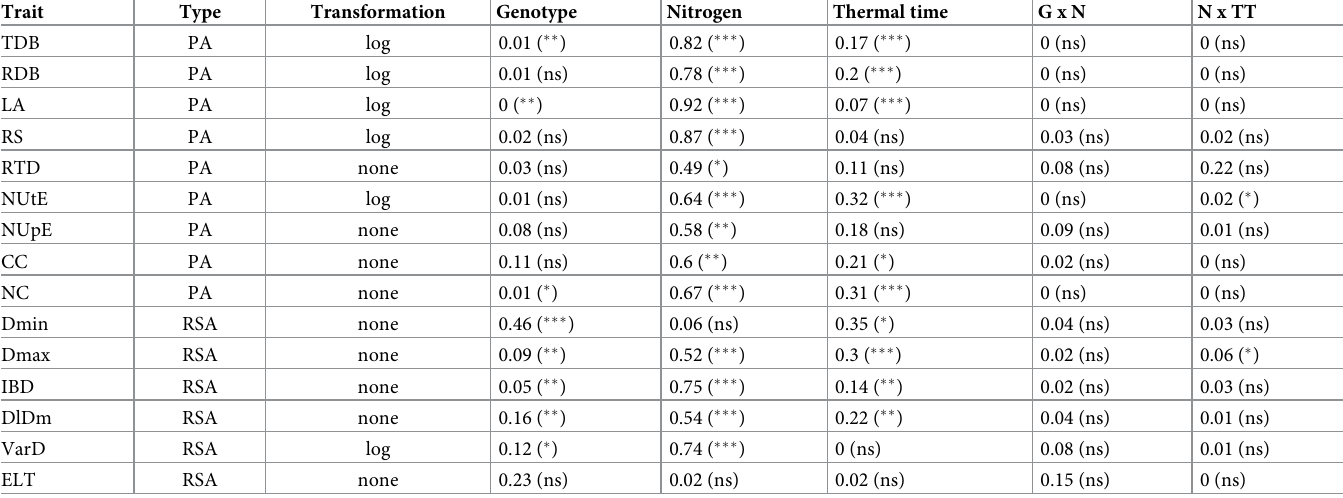
The number in each cell represents a quantification of the impact of the effect (ratio between the mean square of the effect and the total sum of squares). The column “Transformation” indicates which traits were log-transformed before covariance analyses. The number of stars indicates the significance level ( ��� : pvalue < 0.001; �� : pvalue < 0.01; � : pvalue < 0.05; ns: non-significant effect).